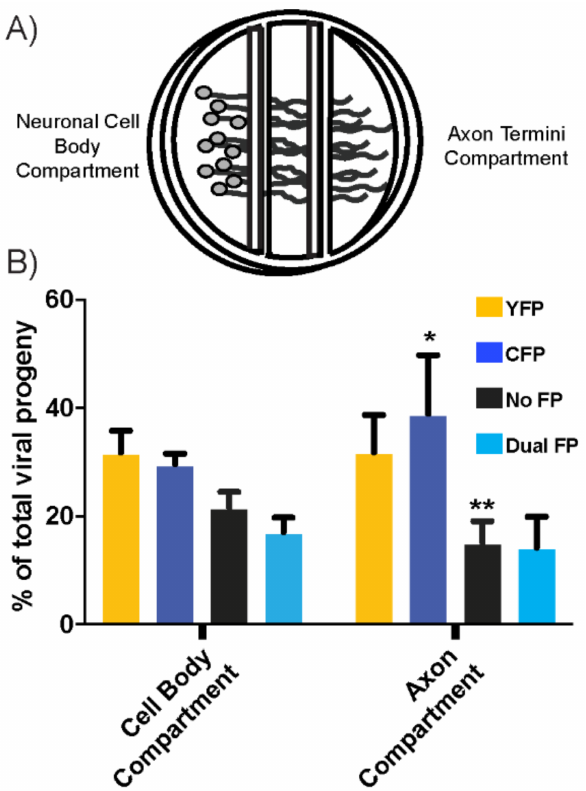
Figure 4. Effect of transneuronal spread on populations of recombinant viruses. ( A ) A schematic representation of the compartmentalized neuronal culture system. Briefly, a Teflon ring is attached to the culture surface. Dissociated superior cervical ganglions (SCG) neurons are plated in the left cell body compartment. Those cell bodies extend axon projections under the two internal walls, resulting in isolated axon termini in the Axon Compartment. Prior to infection, detector cells (not depicted in diagram) are plated in the axon compartment to amplify infectious progeny that transmit via axon-to-cell spread; ( B ) after 48 h of the cell body compartment inoculation, both compartments were harvested and plated at limiting dilution. The plaques developing from the viral progeny were analyzed for the distribution of FP expression in the cell body and axon compartments. * denotes p < 0.05, ** denotes p < 0.005 as identified through pairwise t -test